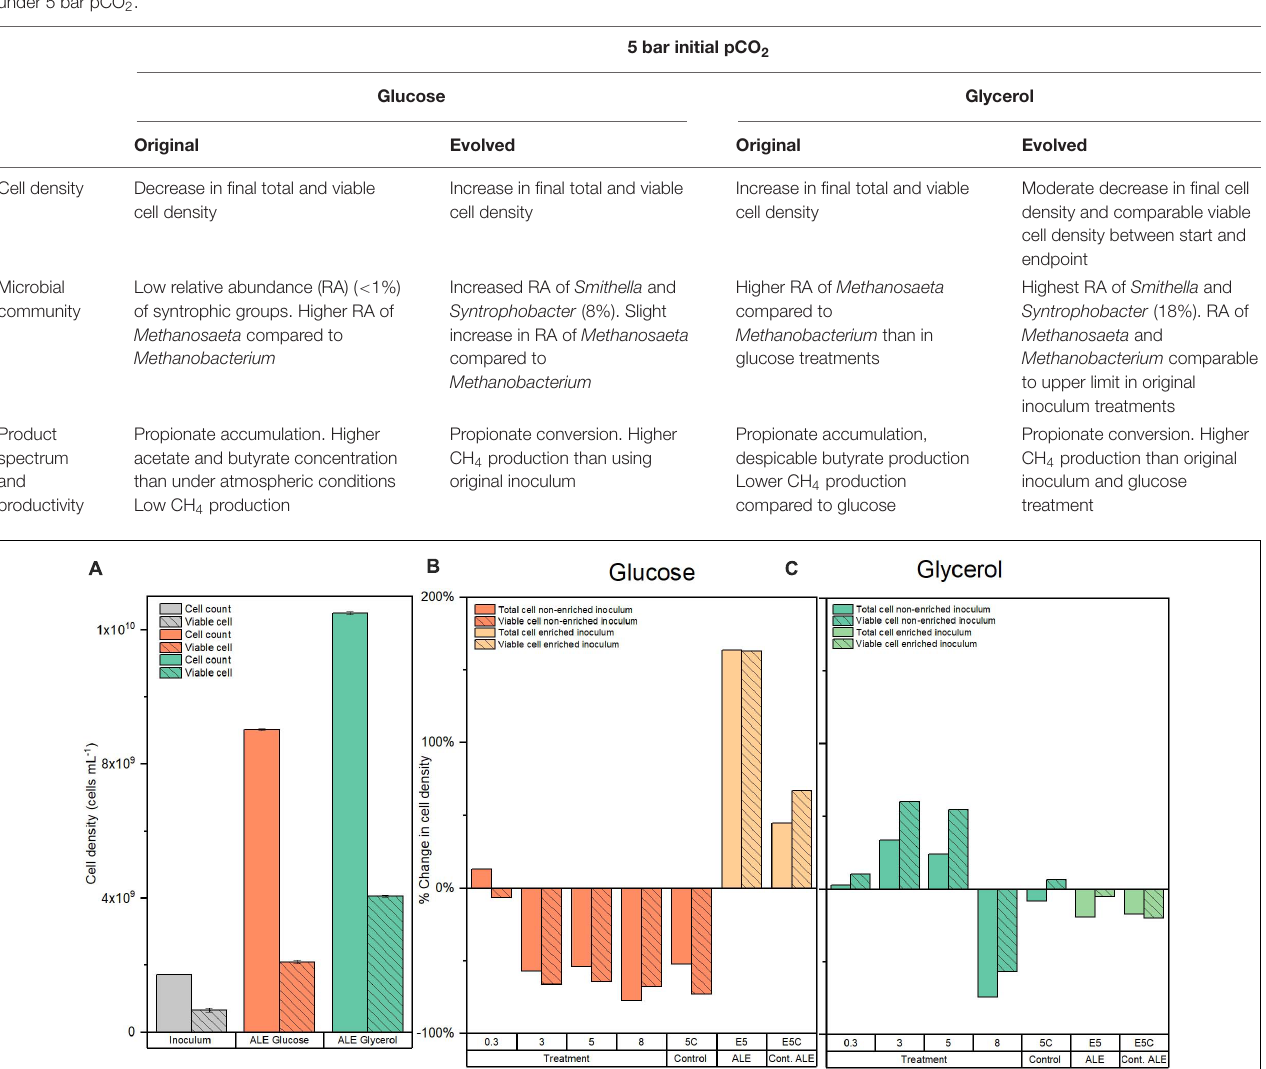
TABLE 2 | Summary of the observed effects of the Adaptive Laboratory Evolution (ALE) strategy in the performance of anaerobic conversion of glucose and glycerol under 5 bar pCO 2